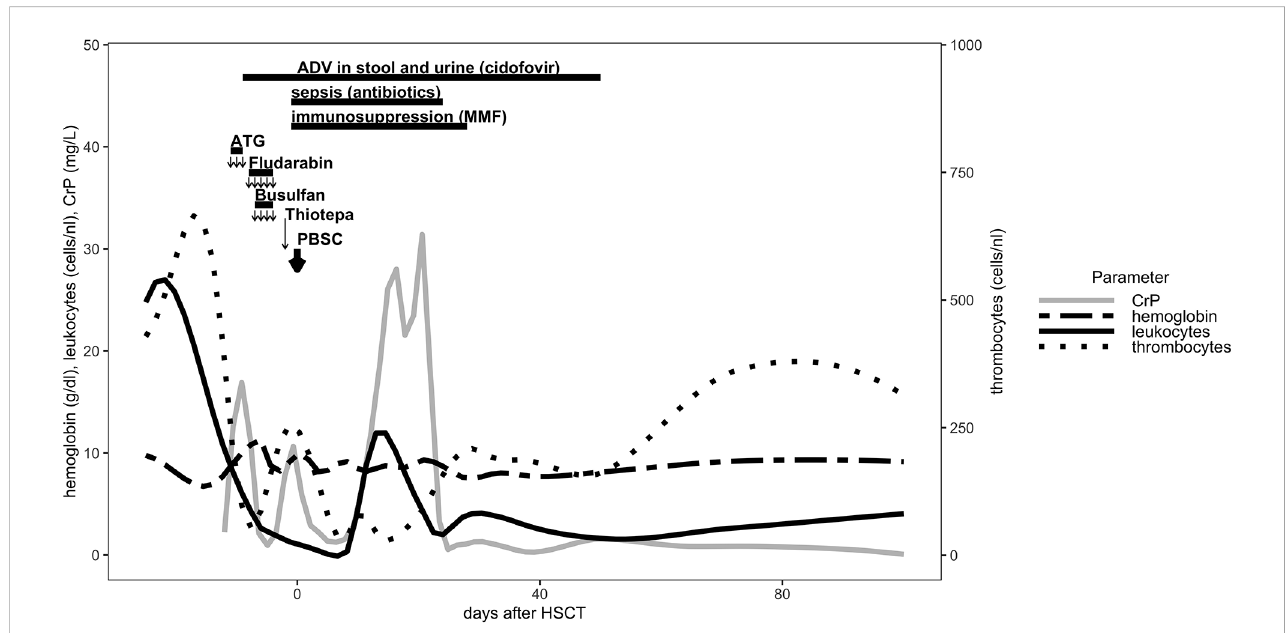
FIGURE 1 Conditioning regiment, immunosuppression and cellular reconstitution are shown for the fi rst 100 days post HLA-haploidentical